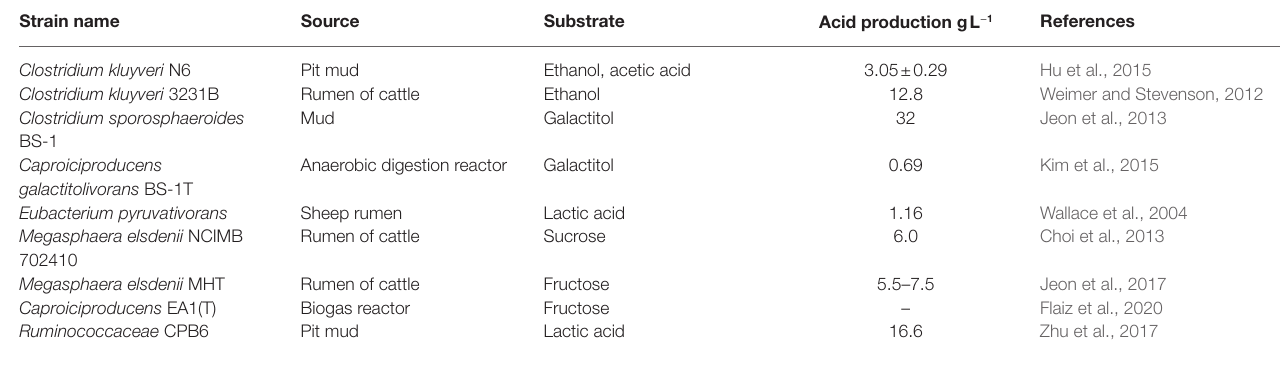
TABLE 1 | Types of caproic acid-producing bacteria and acid